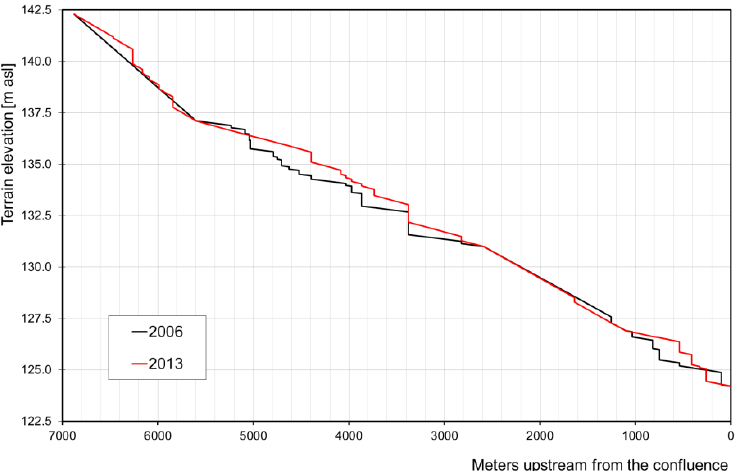
Figure 2. Longitudinal profile of the first 7 km of the Krzemianka River in 2006 and 2013 (distance measured from the confluence of